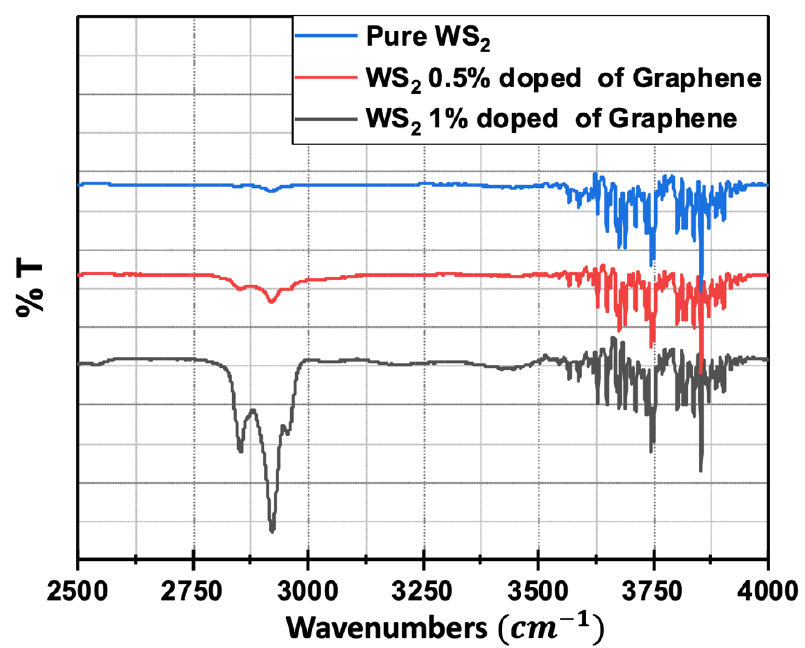
Figure 6. FTIR absorption spectra of WS 2 , WS 2 : 0.5 wt% Gr, and WS 2 : 1 wt% Gr. Note the presence of the typical graphene absorption peak at 2780 – 3000 𝑐𝑚 −1 for both graphene@WS 2 samples.